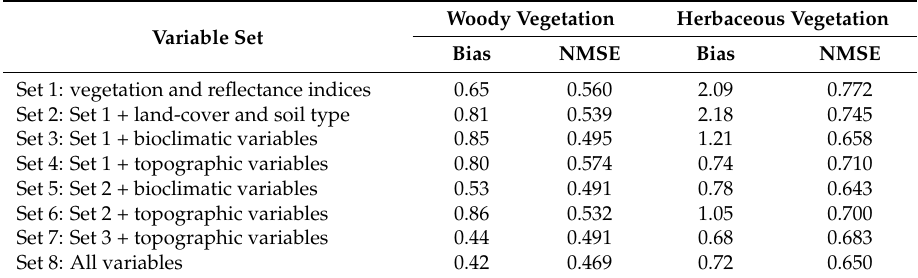
Table 2. Performance statistics derived from Random Forest models. The combination of absolute deviation and normalized mean square error (NMSE) indicates the estimation accuracy of models with different input datasets.